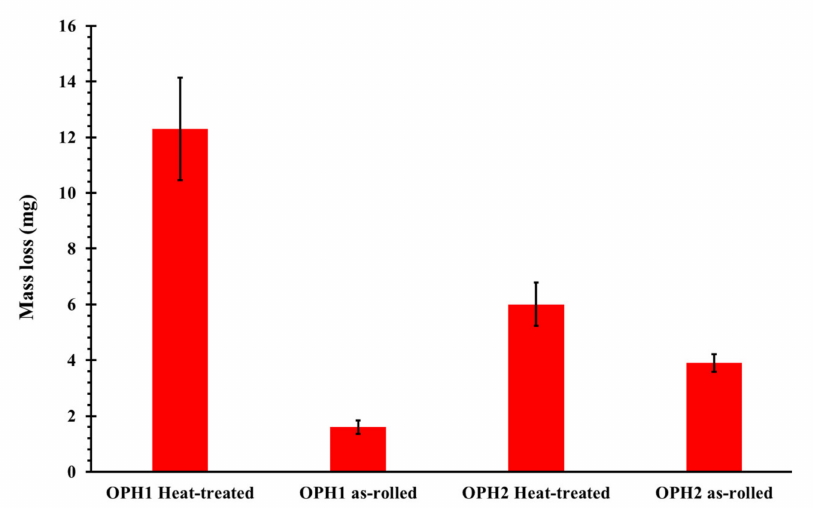
Figure 11. Mass loss measured from the pin-on-disk